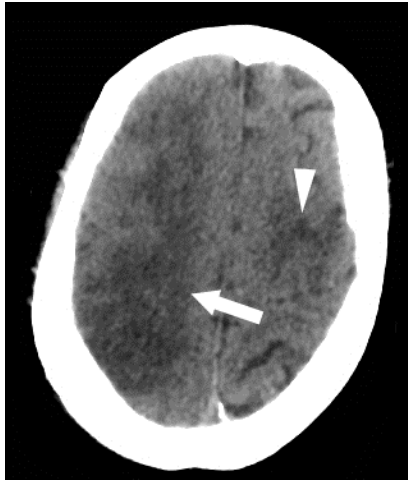
Figure 6. Clinical illustration of an arterial air embolism in a patient with patent foramen ovale (PFO) can be seen in the following example in which a 57 ‐ year ‐ old female underwent liver resection. At the end of the case, the patient became profoundly hypotensive, and an air embolism was suspected. Approximately 20 cc of air was aspirated from an indwelling central venous catheter, an Extracorporeal membrane oxygenation (ECMO) was initiated and the patient was transferred to ICU where CT brain was performed. An axial CT shows multiple areas of low attenuation representing infarction of the right (arrow) and left (arrowhead) cerebral hemispheres, consistent with underlying embolic source of infarct. Furthermore, the CT shows loss of gray ‐ white differentiation consistent with cerebral edema. Transesophageal echocardiography was performed (not shown), revealing a large amount of air bubbles in the right and left chambers heart chambers. This, together with a patent foramen ovale, resulted in paradoxical embolism.